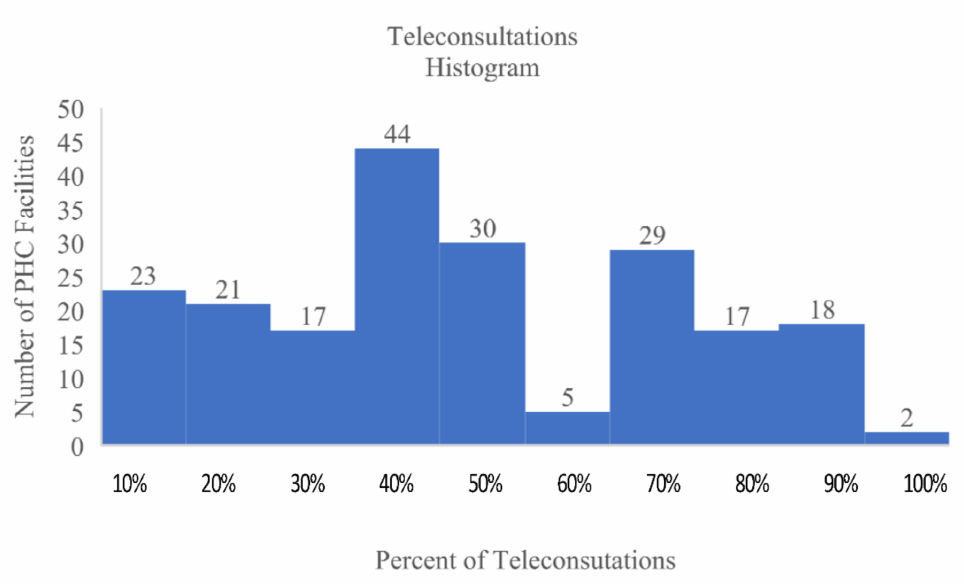
Figure 2. Percentage of teleconsultations provided monthly by primary healthcare